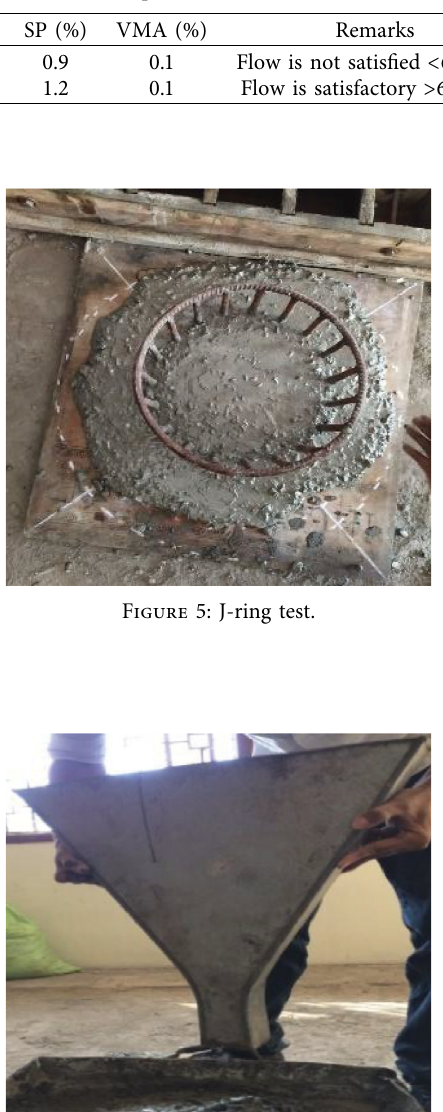
Table 4: Trail mix proportions as per IS 10262-2019 code of practice.